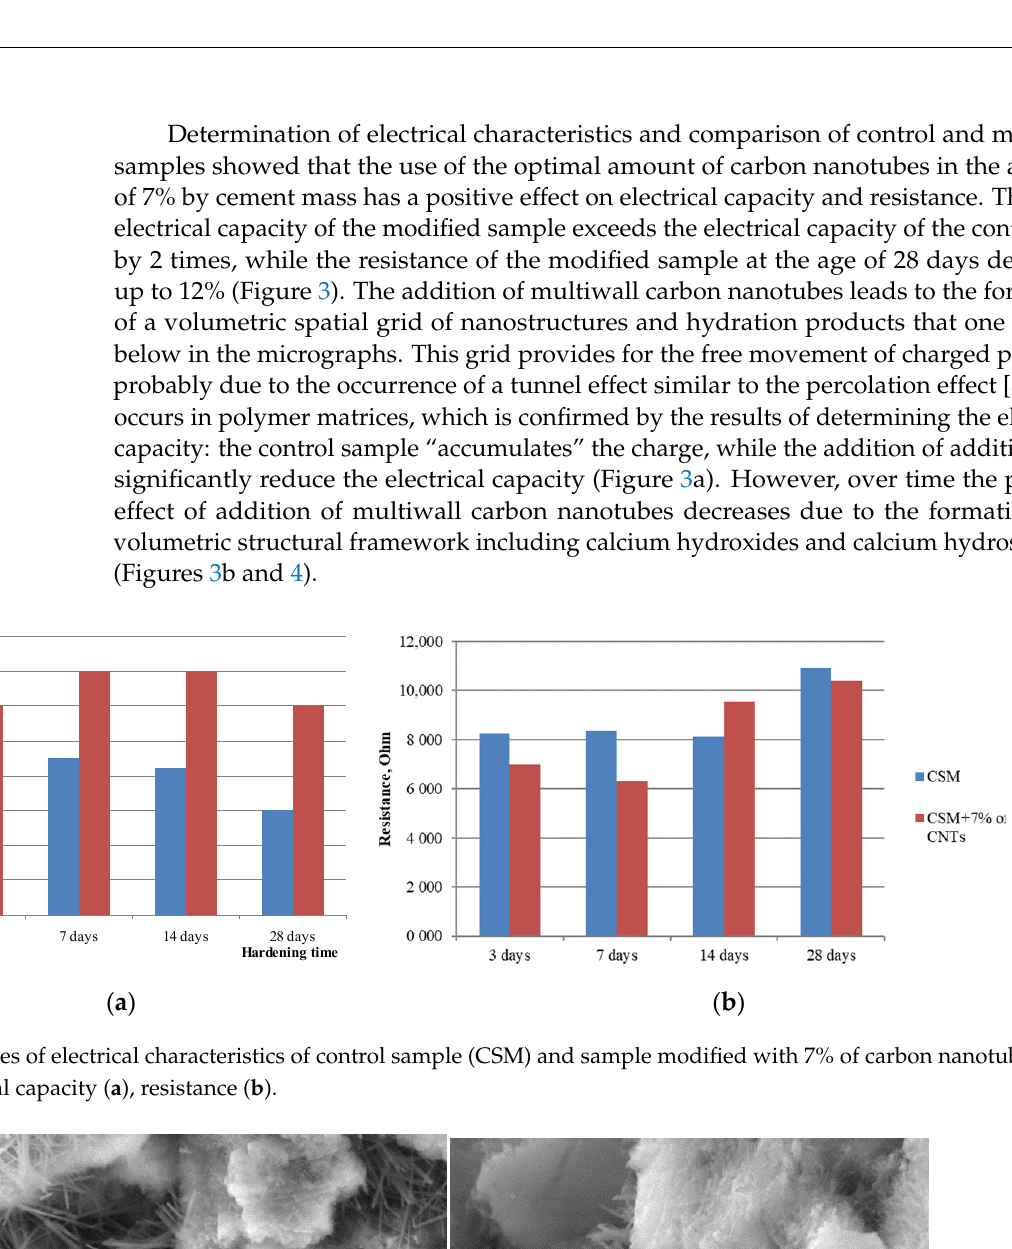
Figure 2. Strength characteristics in different periods of hardening: Flexural strength ‐ ( a ), compres ‐ sive strength ‐ ( b ).